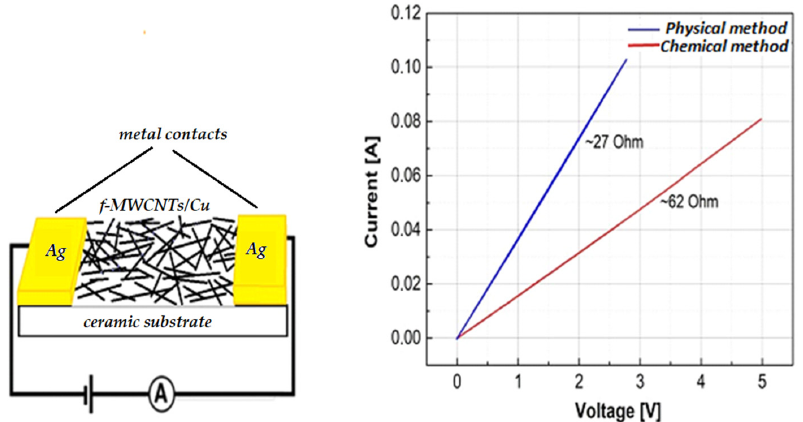
Figure 1. Sensor structure ( left ) and I-V characteristics of the Ag-f-MWCNTs/Cu-Ag structures ( right ).